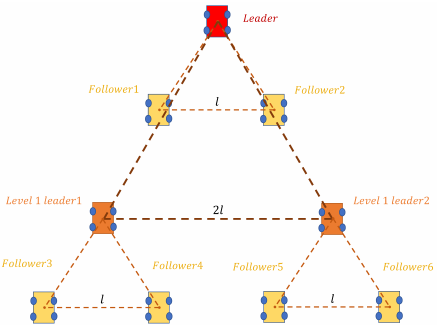
Figure 18. The full double-layer triangle formation for testing. Table 5. List of Parameters Used in the Testing of a Full Double-layer Triangle